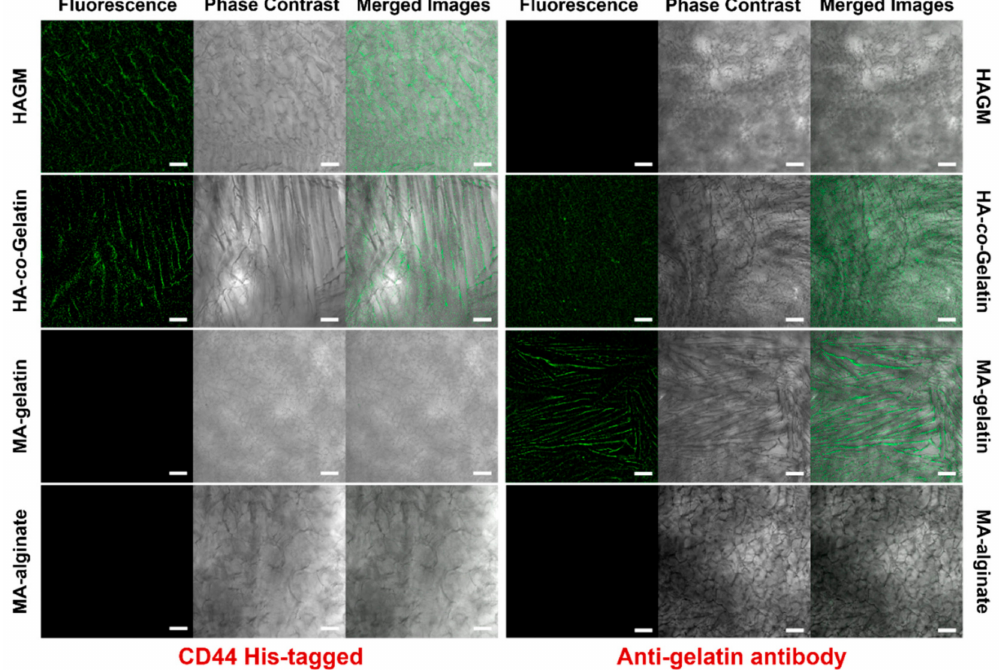
Figure 5. Evaluation of biological properties of cryogels. Immunostaining of HAGM, MA-gelatin, HA- co -Gelatin, and MA-alginate cryogels using human CD44 His-tagged receptor and anti-gelatin antibody. CD44 binding was depicted with an Alexa Fluor 488-conjugated 6x-His Tag monoclonal antibody (green), and anti-gelatin antibody binding was detected with a FITC-conjugated anti-rabbit IgG (green) (scale bar = 100 µ